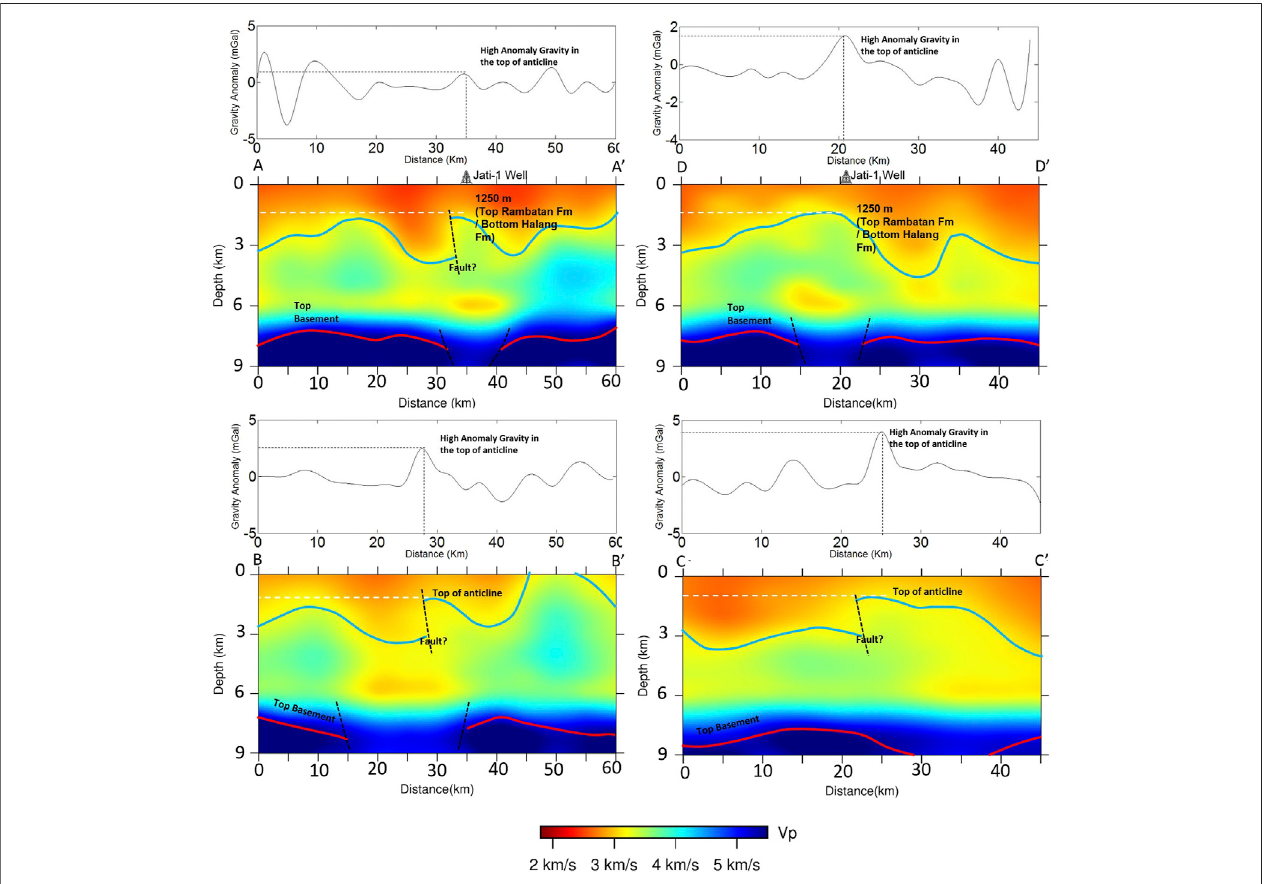
FIGURE11 | The residual gravity anomaly response(Hidayat et al., 2020) and the vertical cross sections of Vp which pass through the Jati-1 well insections A – A ′ , D – D ′ , B – B ′ , and C – C ′ . Blue line indicates geological contact between the Halang Formation and the Rambatan Formation, which is also con fi rmed by interpretation of Jati-1 well (Tampubolon et al., 2014). We also interpreted top of basement based on the high-velocity anomaly ( > 5 km/s) which is shown by red line.